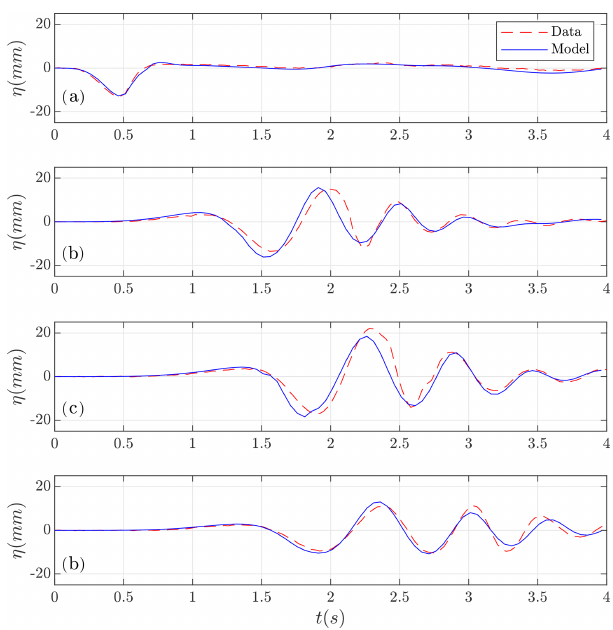
Figure 7. Test case d = 61mm. Numerically computed (in blue) time series at wave gauges (a) g 1 , (b) g 2 , (c) g 3 , and (d) g 4 com- pared with the lab-measured data (in red).